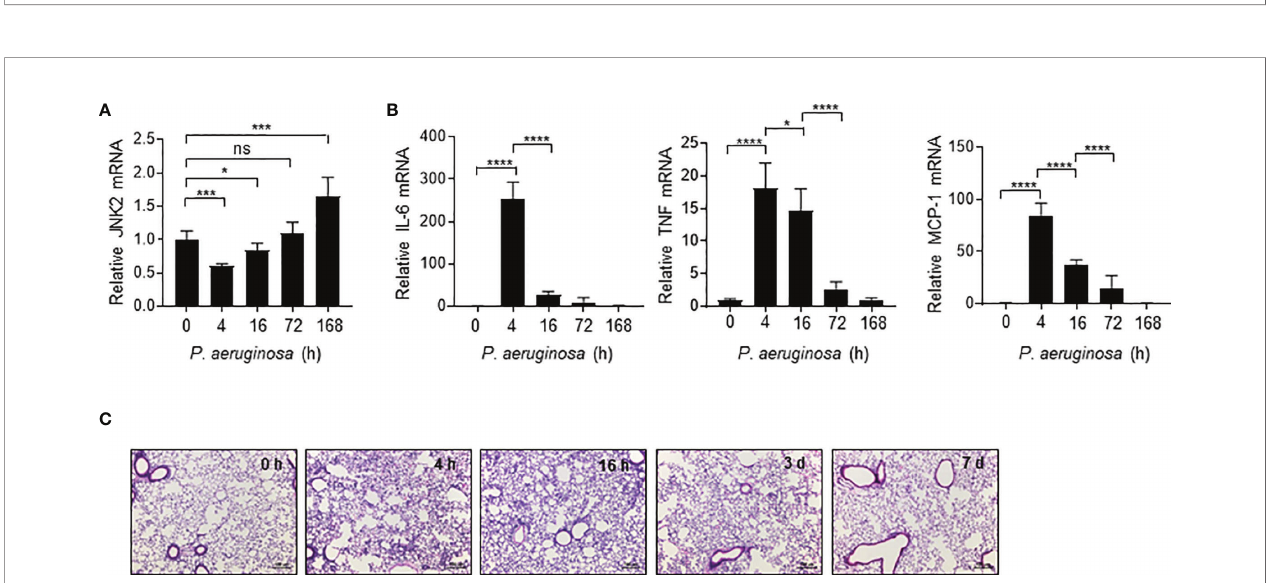
FIGURE 5 | JNK2 mRNA levels are negatively correlated with lung injury severity during pseudomonas pneumonia. mRNA expressions of JNK2 (A) or in fl ammatory cytokines (B) in whole lung homogenates or lung histology by H&E staining (C) from wild-type mice treated with i.n. pseudomonas aeruginosa (strain PA103) for different times as indicated. N=3-6. Data are presented as means ± sem. * p < 0.05; *** p < 0.001; **** p < 0.0001; ns, not signi fi